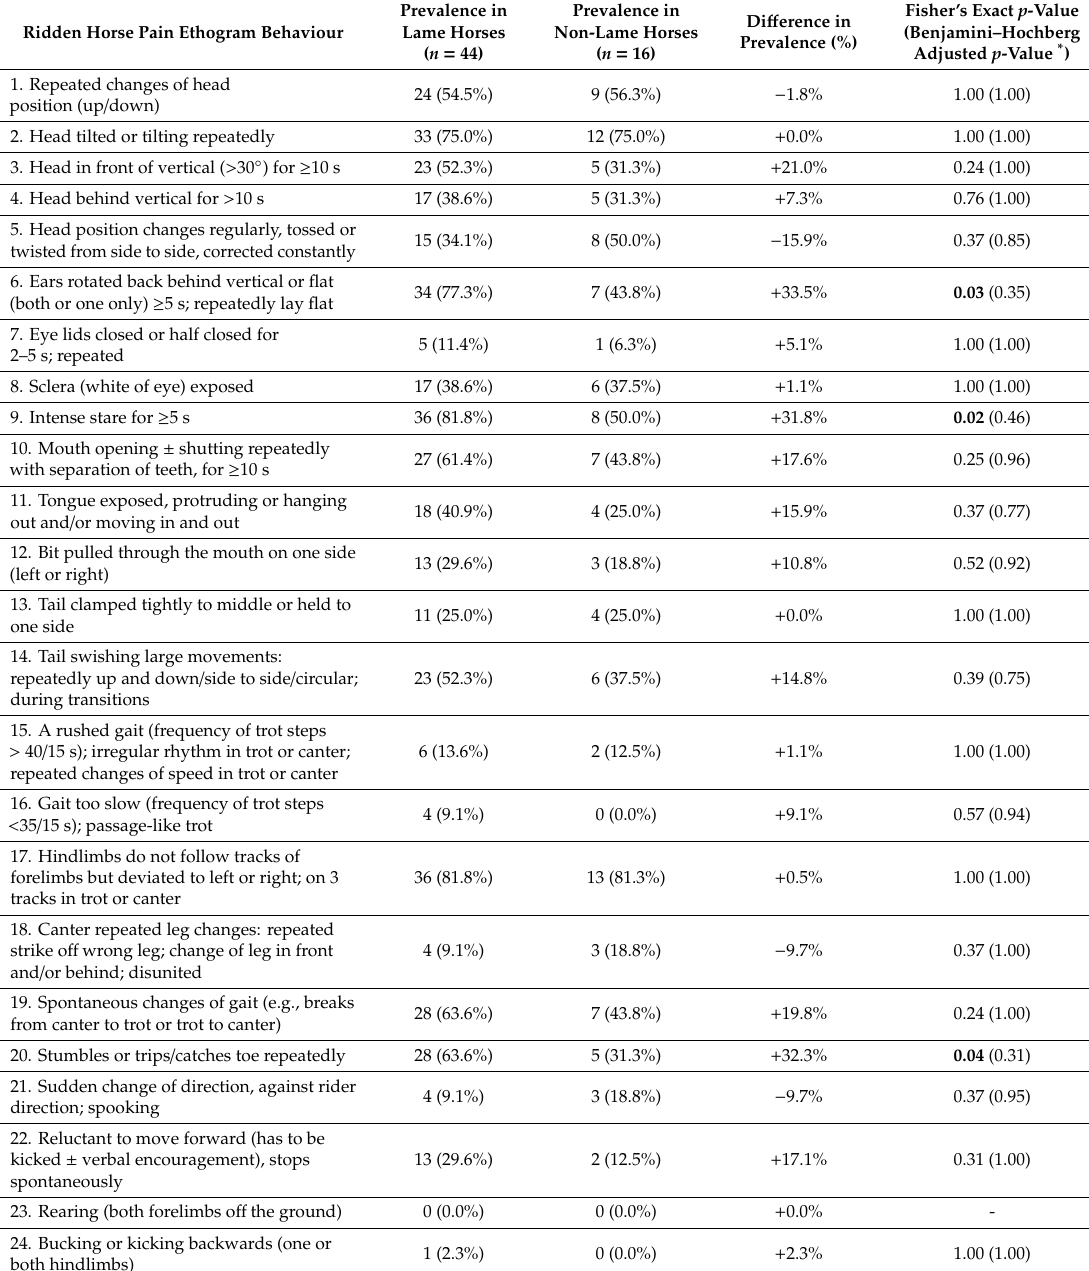
Table 2. The prevalence, di ff erence in prevalence and Fisher’s exact p -value of 24 Ridden Horse Pain Ethogram behaviours compared between lame and non-lame ridden horses ( n =